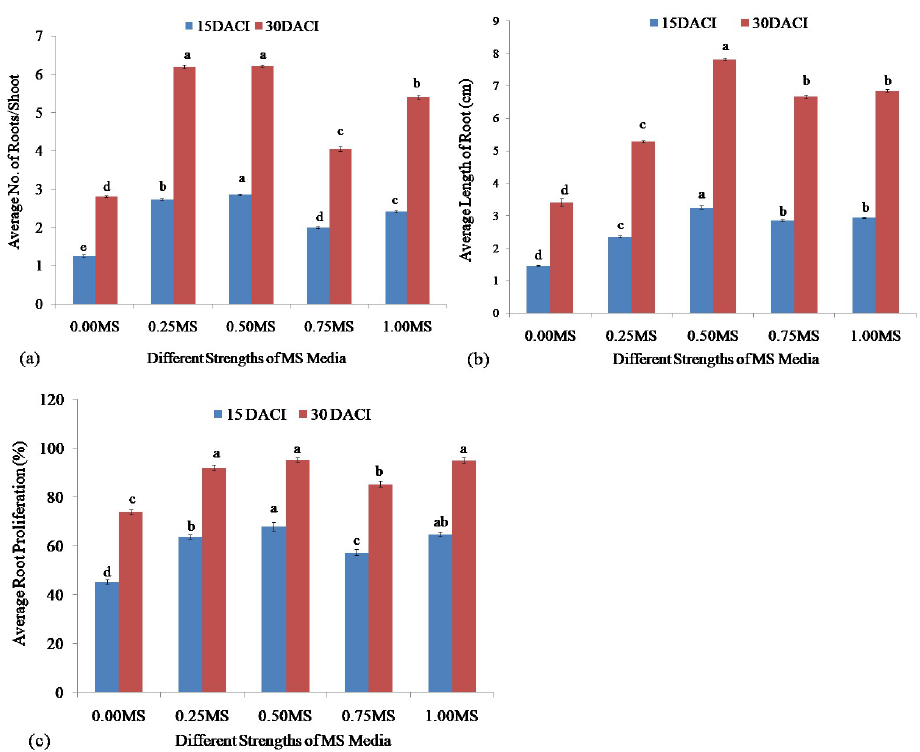
Figure 7. Root initiation of stevia from shoot grown on different strengths of MS media at 15 and 30 days after inoculation (DACI): ( a ) No. of roots initiated per shoot; ( b ) length of induced roots; and ( c ) percentage of root production. Bars denote the mean of three replications per treatment ± SE (Standard Error). Mean values with the same letters are not significantly different based on the Student’s t -test at p = 0.05 .